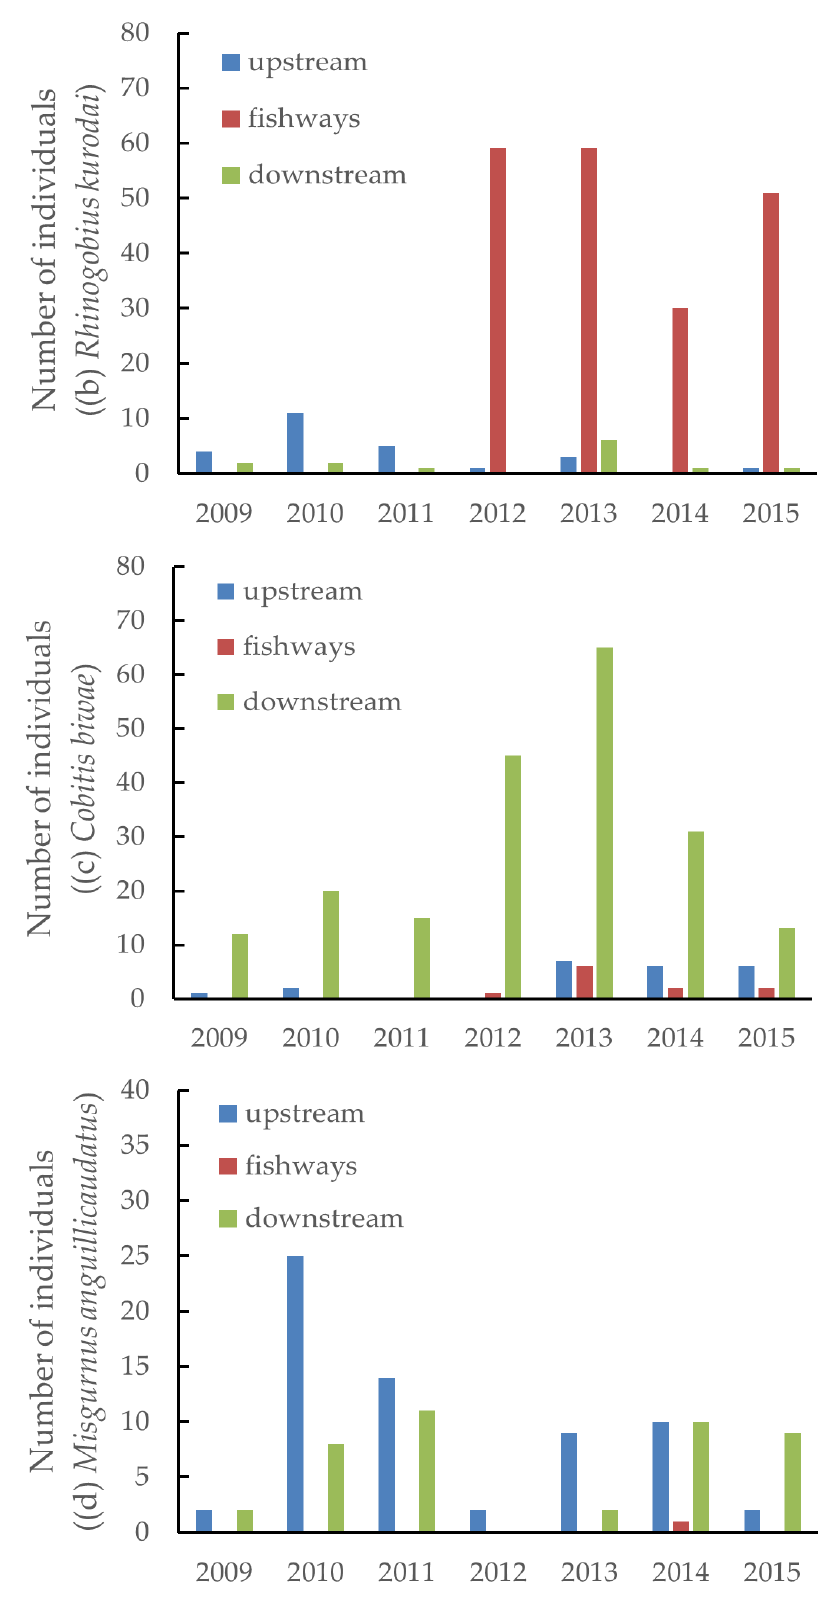
Figure 5. Numbers of bottom-dwelling species ( a ) C. pollux and ( b ) R. kurodai in the upstream zone, fishways, and downstream zone, as confirmed by the 2009–2015 survey. Independent numbers of bottom-dwelling species ( c ) C. biwae and ( d ) M. anguillicaudatus in the upstream zone, fishways, and downstream zone, as confirmed by the 2009–2015 survey.